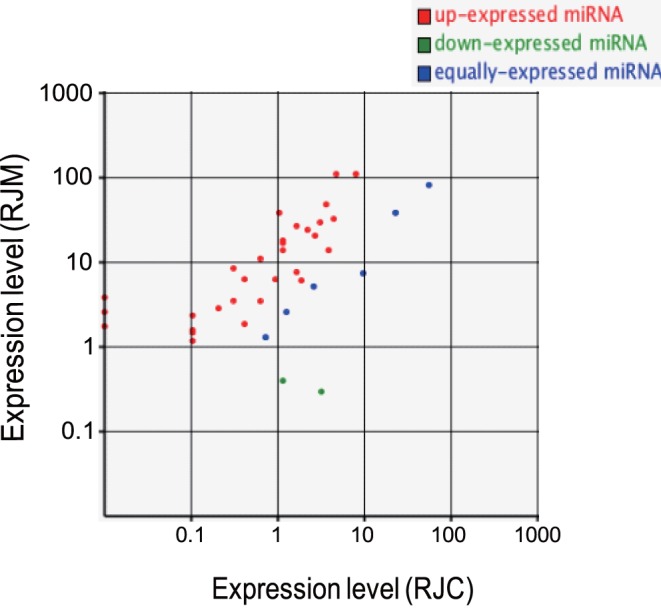
Differential expression analysis of miRNA in RJM and RJC.Expression levels were indicated on Y (RJM) or X (RJC). Expression levels were considered different if the threshold of false discovery rate (FDR was 0.001 and the absolute value of log2 Ratio was 1).